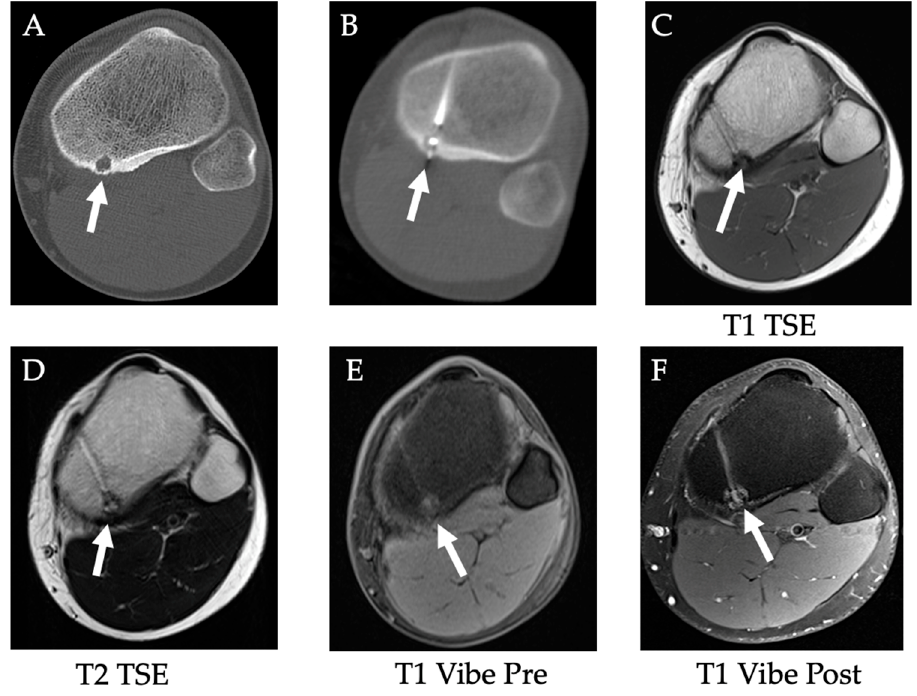
Figure 17. Radiofrequency ablation of osteoid osteoma . ( A ) A well-corticated osteoid osteoma with hypodense nidus (white arrow) in the posteromedial tibial metaphysis, ( B ) treated with RFA. ( C – F ) 5-month follow-up MR images show treated osteoid osteoma without residual